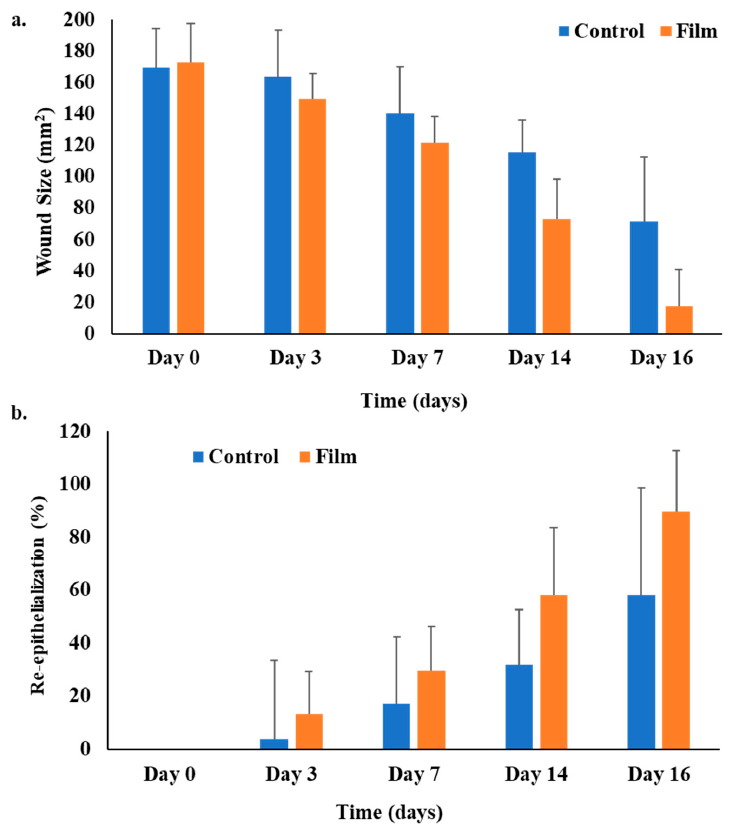
Figure 8. ( a ) Wound sizes (mm 2 ) and ( b ) percentage re-epithelialization in the diabetic